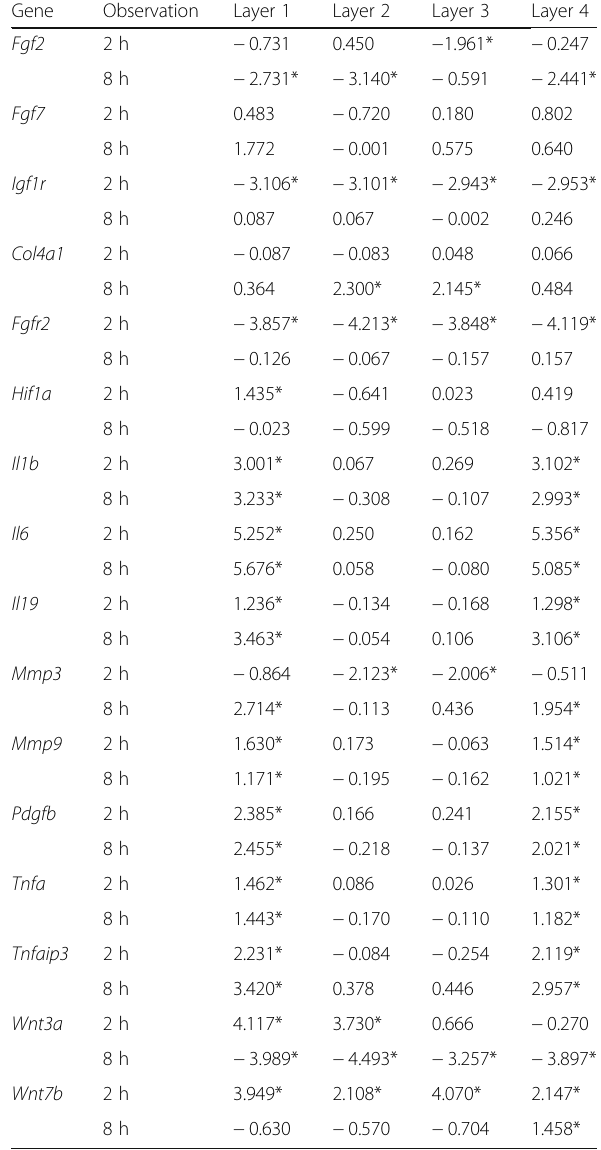
Table 1 Summary of microarray results Gene